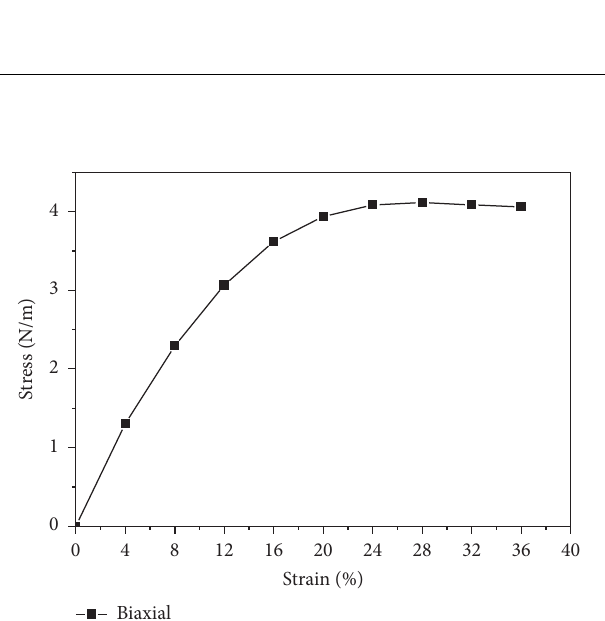
Figure 1: The relationship between biaxial strains and pressures of monolayer